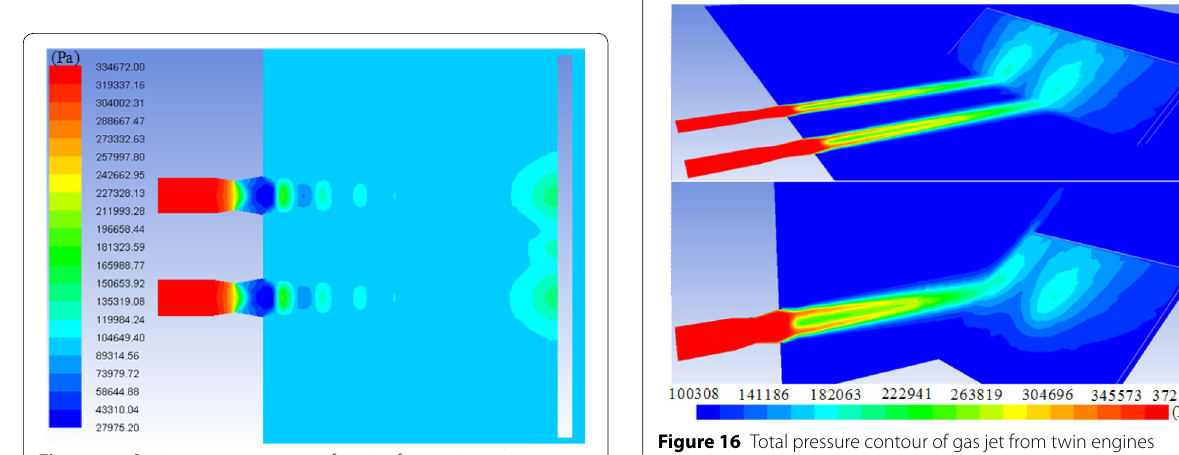
Figure 14 Static pressure contour of gas jet from twin engines